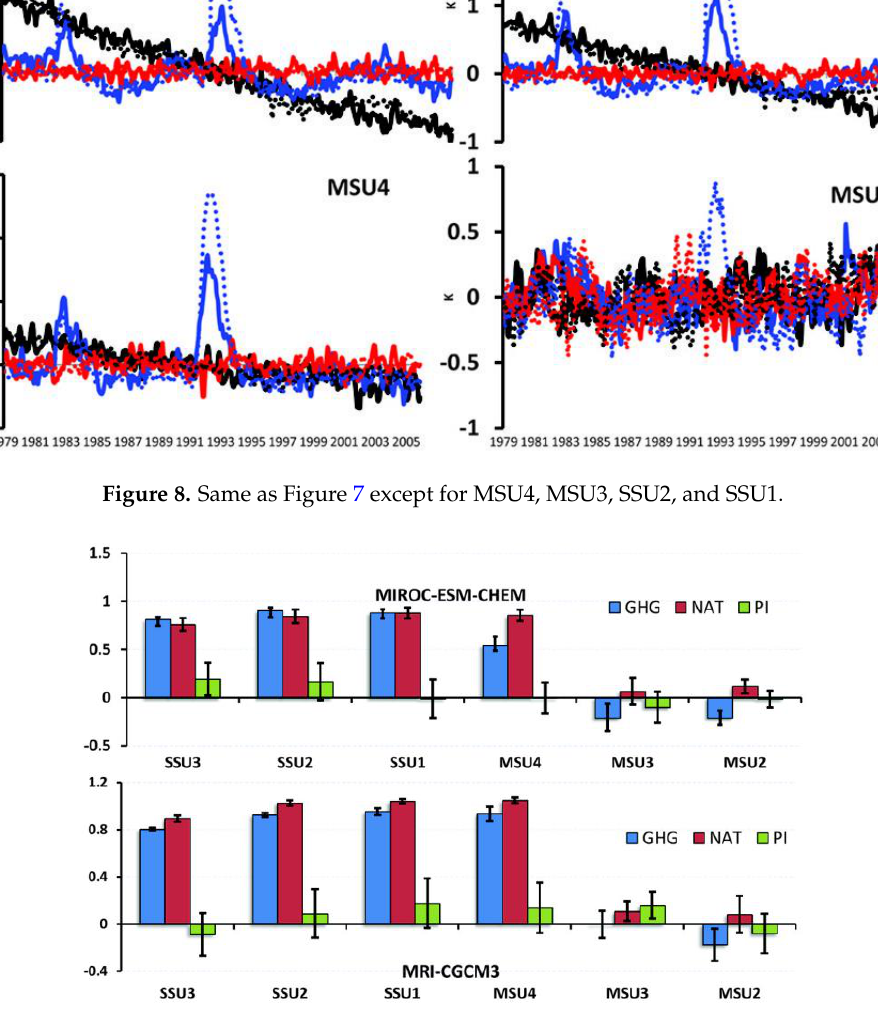
Figure 9. Regression coefficients derived from the regression of historical global mean temperatures’ time series with greenhouse gases forced run (GHG) natural forced run (NAT) and pre-industrial control run (PI) (error bar: 95% confidence intervals for the coefficient estimates).